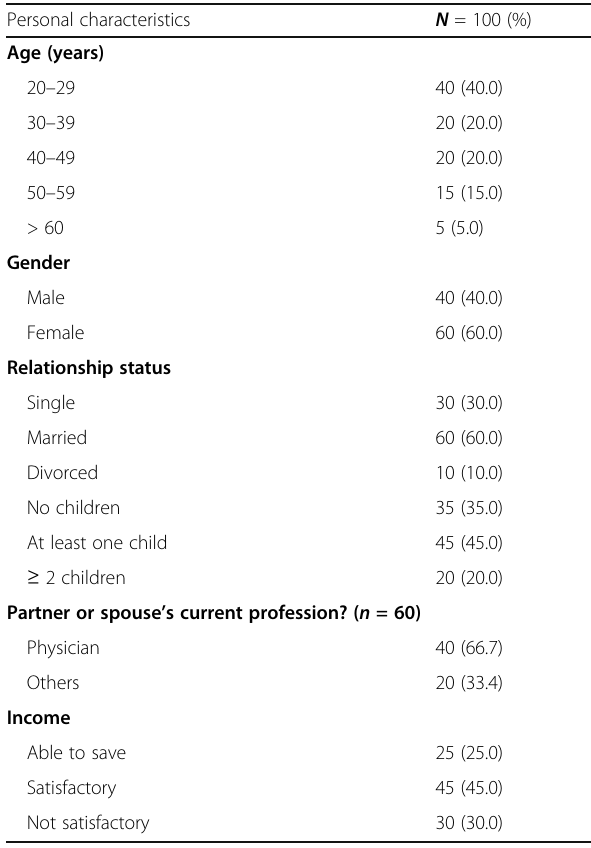
Table 1 Sociodemographic characteristics of the studied